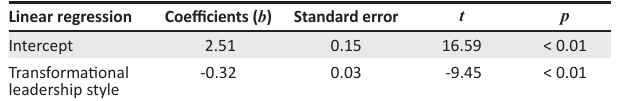
TABLE 2: Correlations between transformational leadership style and turnover intention.